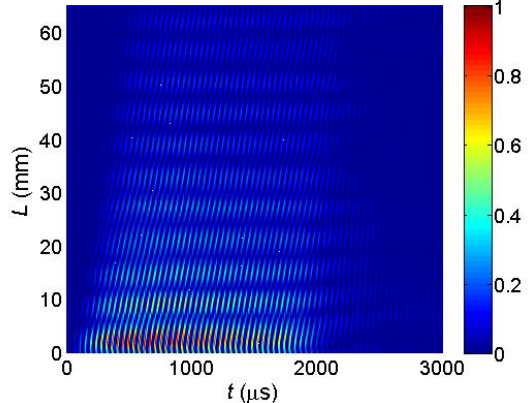
Figure 31. Measured B-Scan of the normal displacements of the PVC film when all array elements were excited simultaneously.